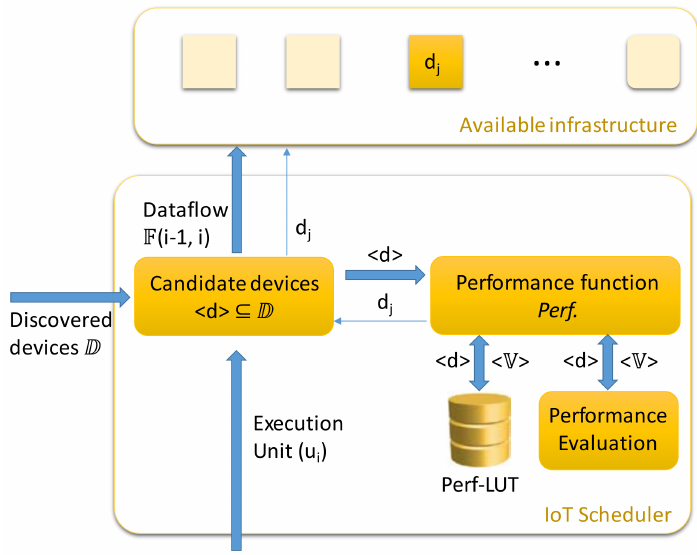
Figure 3. IoT scheduler design.